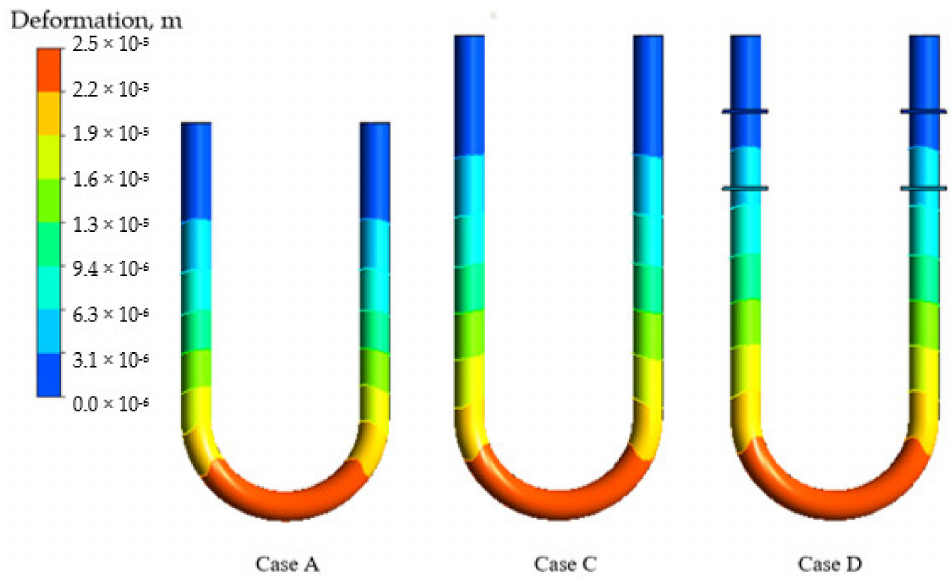
Figure 8. Tube deformation for 8 m/s for the shear stress turbulence